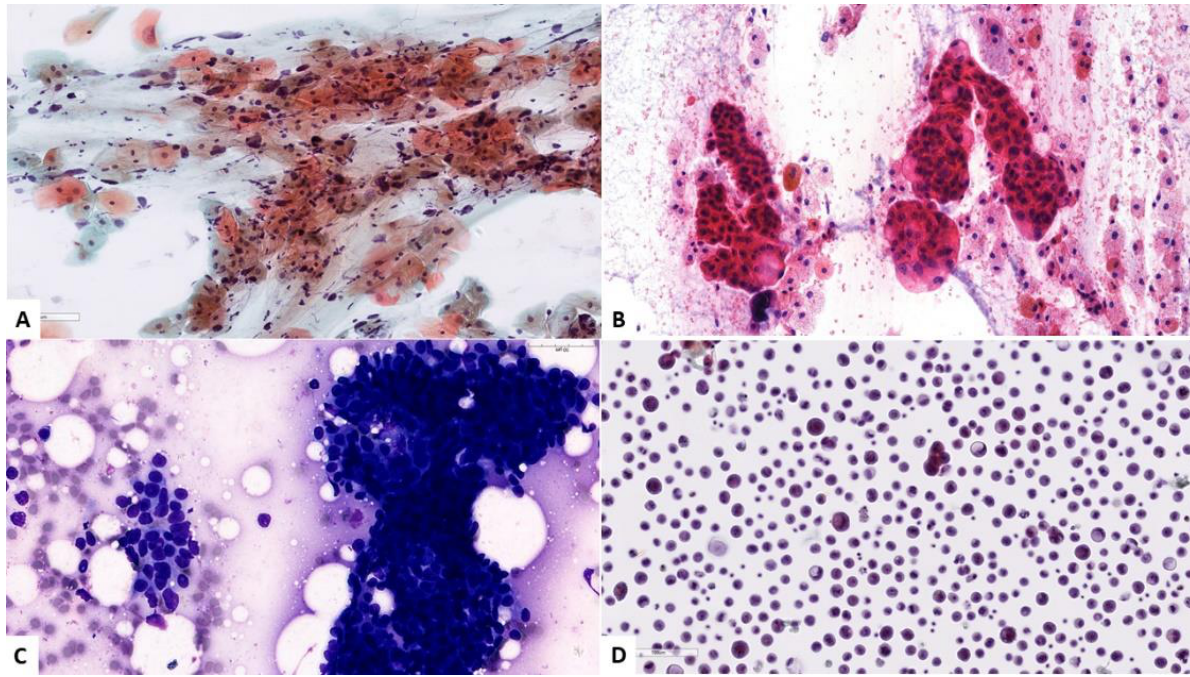
Figure 7. Examples of cytological images. ( A ) Conventional smear from uterine cervix of a 30-year-old female showing high-grade squamous intraepithelial lesion (HSIL) (Pap stain, ×20). ( B ) Conventional smear from a salivary gland mass of a 30-year-old female patient, showing intraductal carcinoma (H&E stain, ×20). ( C ) High-power view of a conventional smear from a 64-year-old male patient with a submandibular gland nodule, showing adenoid cystic carcinoma (Diff-Quik stain, ×40). ( D ) Ascitic fluid liquid-based preparation from a 79-year-old female patient with a history of colon carcinoma showing metastatic colon carcinoma (Pap stain, ×20).